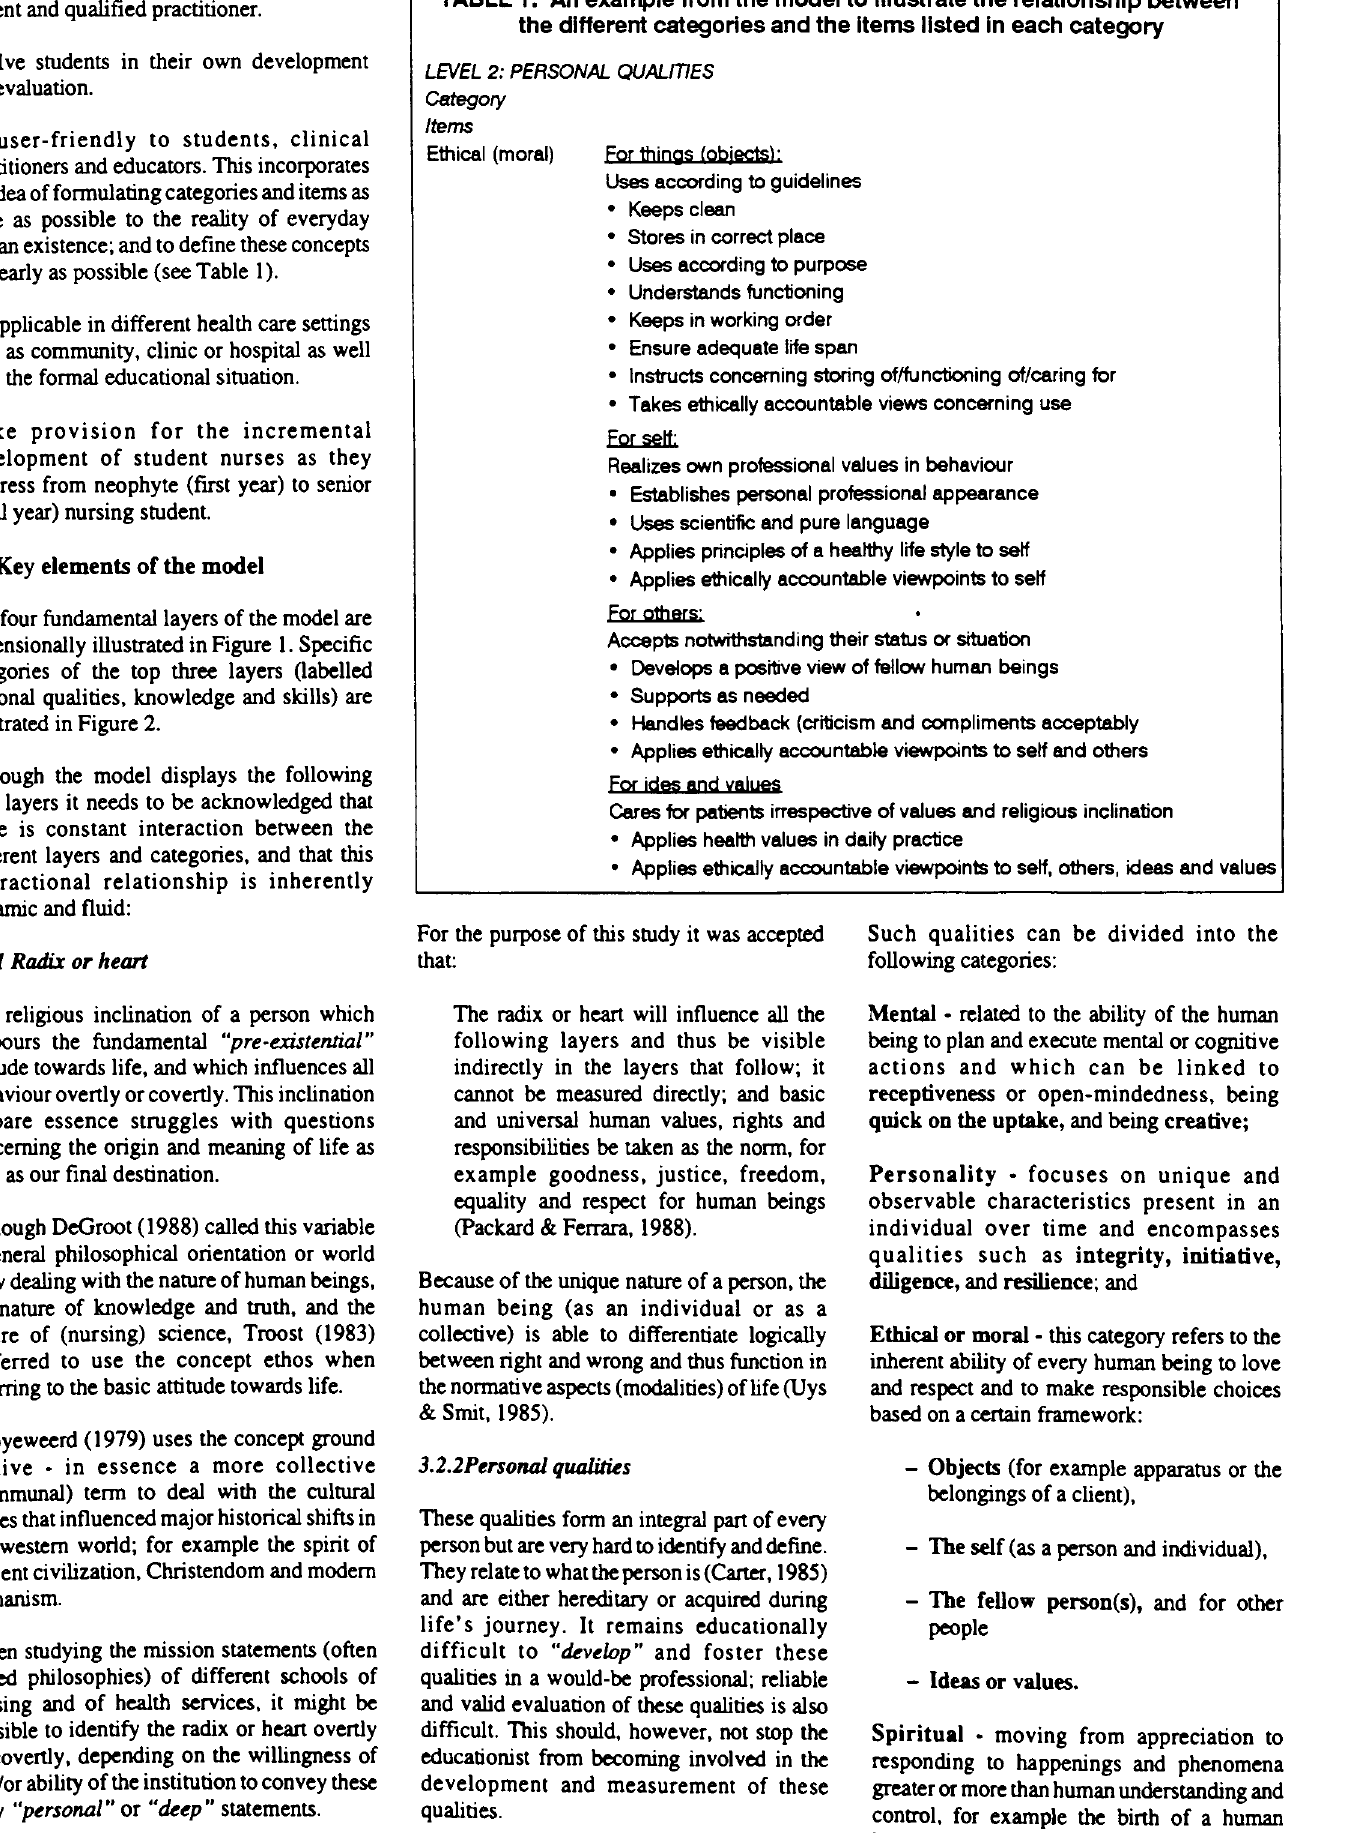
TABLE 1: An example from the model to illustrate the relationship between the different categories and the items listed in each